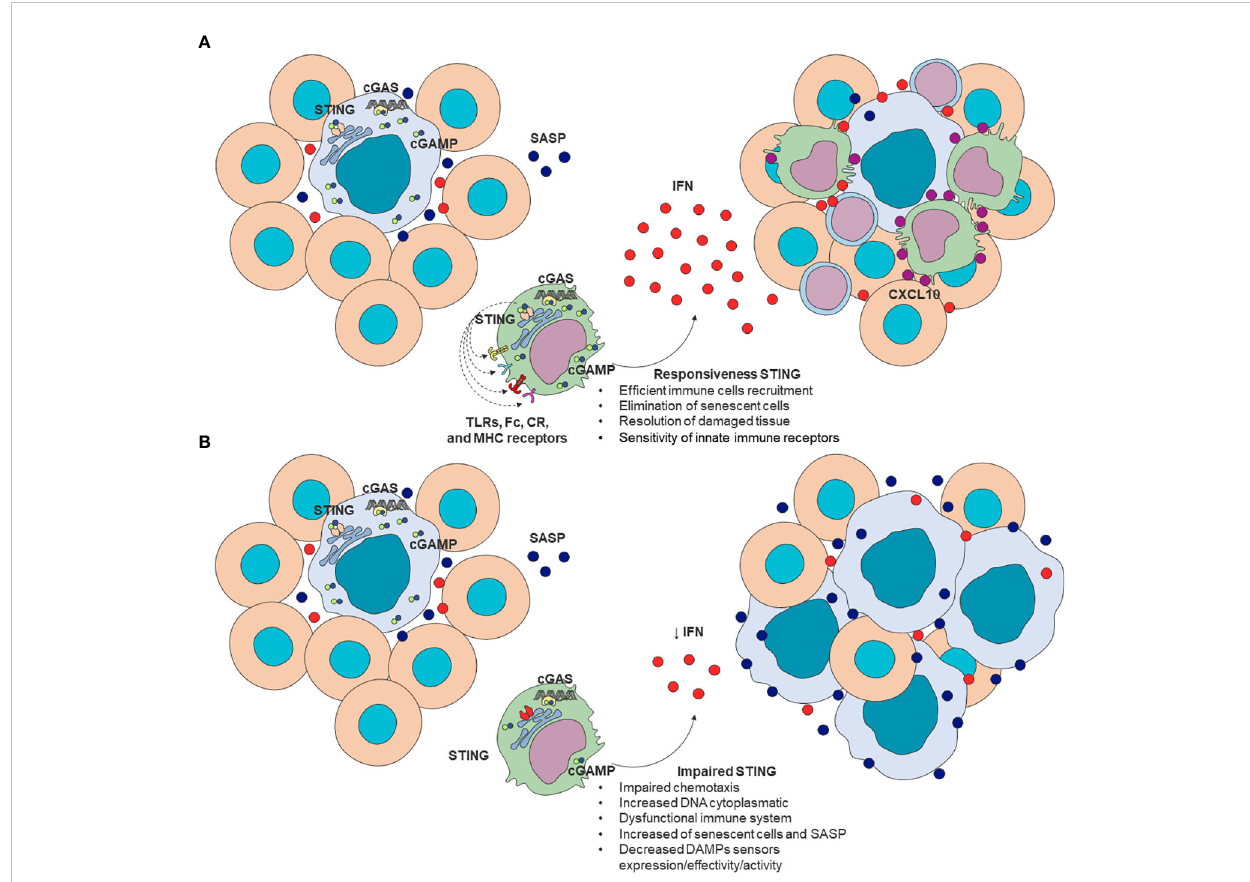
FIGURE 2 A proposed model of STING as a modulator of immunosenescence. (A) Effective STING response is required for ef fi cient immune cell recruitment, elimination of senescent cells, and damaged tissue repair. (B) Impaired STING signaling can be associated with increased cytoplasmatic DNA, impaired chemotaxis, decreased DNA sensors ’ expression and effectivity, increased frequency of senescent cells and SASP mediators leading to impaired clearance of senescent cells. These alterations are consistent with changes present in aged-immune cells. SASP (blue); T cells chemokines (purple); IFN (red). cGAS, cyclic GMP – AMP synthase; 2 ’ 3 ’ -cGAMP, cyclic guanosine monophosphate-adenosine monophosphate; SASP, senescence- associated secretory phenotype; STING, stimulator of interferon